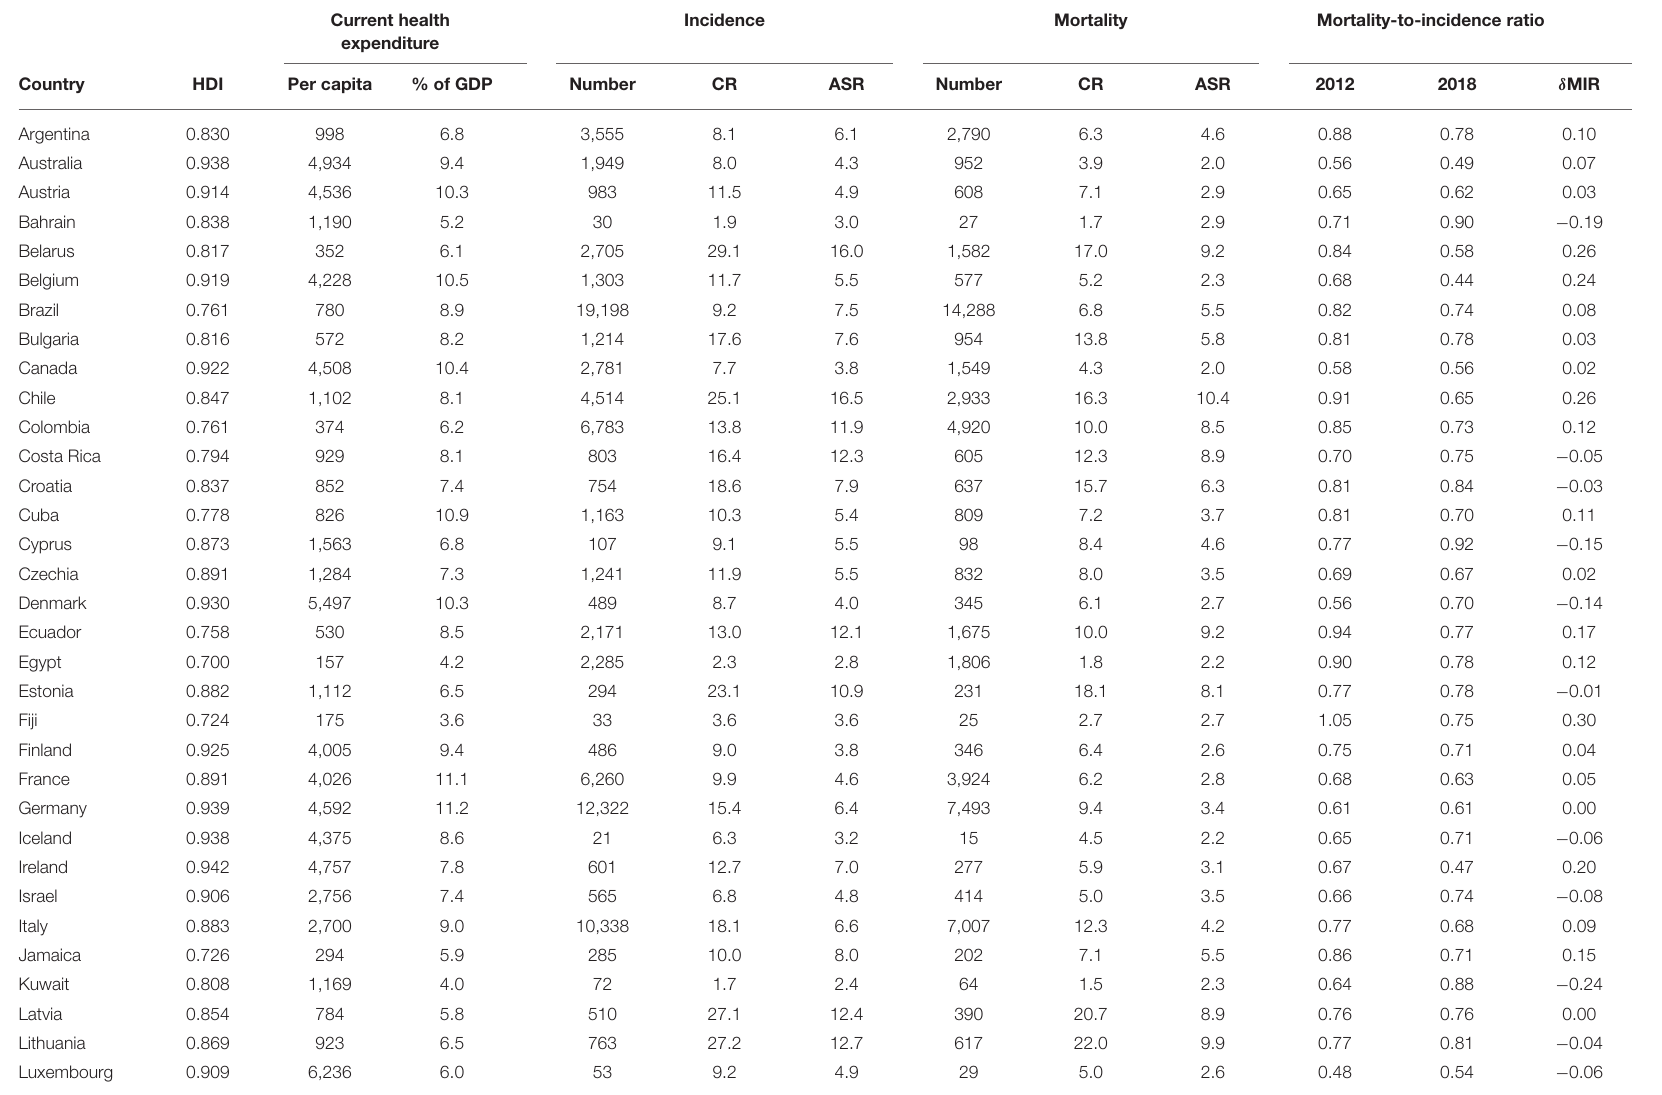
TABLE 2 | Summary of human development index, current health expenditure, cancer incidence, cancer mortality, and mortality-to-incidence ratio in gastric cancer of selected countries ( N =